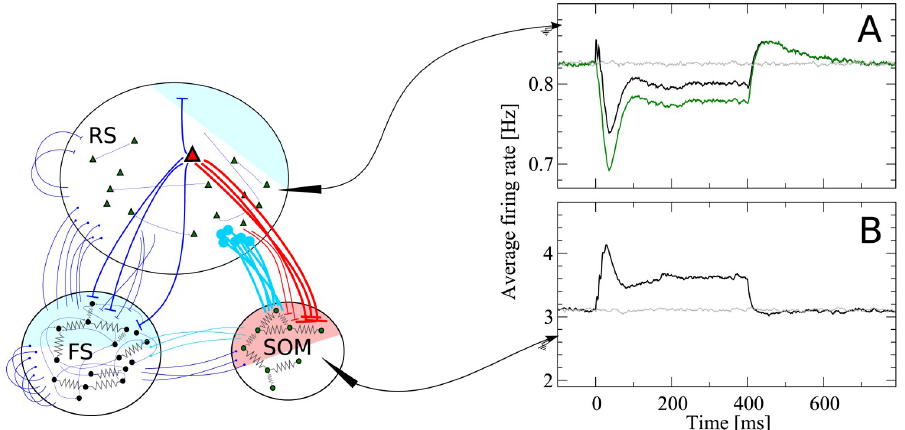
Fig 5. Disynaptic inhibition mediated by somatostatin-positive low-threshold spiking (SOM-LTS) cells causes inhibitory response to the stimulation of a regular spiking (RS) cell. When a RS cell is stimulated (the stimulus is switched here on at t = 0 and off at t = 400 ms), synapses from the stimulated cell (red triangle) to the SOM-LTS population strongly facilitate and cause a large increase in the firing rate of the SOM population, which then relaxes back to a plateau because of the spike-frequency adaptation (panel B , black line). The inhibitory input from the SOM to the RS population produces a response in the RS cells which is almost a mirror image ( A , black line). The initial positive peak in the RS response is due to the spikes fired by the stimulated cell itself, as can be seen by excluding it from the population ( A , green line). The curves in panels A and B are averages over 10000 trials and spikes are filtered with an exponential filter with decay constant τ f = 15 ms. Gray lines indicate catch trials (no stimulation). Colored shaded areas indicate the approximate fraction of the three populations which have a direct synaptic connection with the stimulated